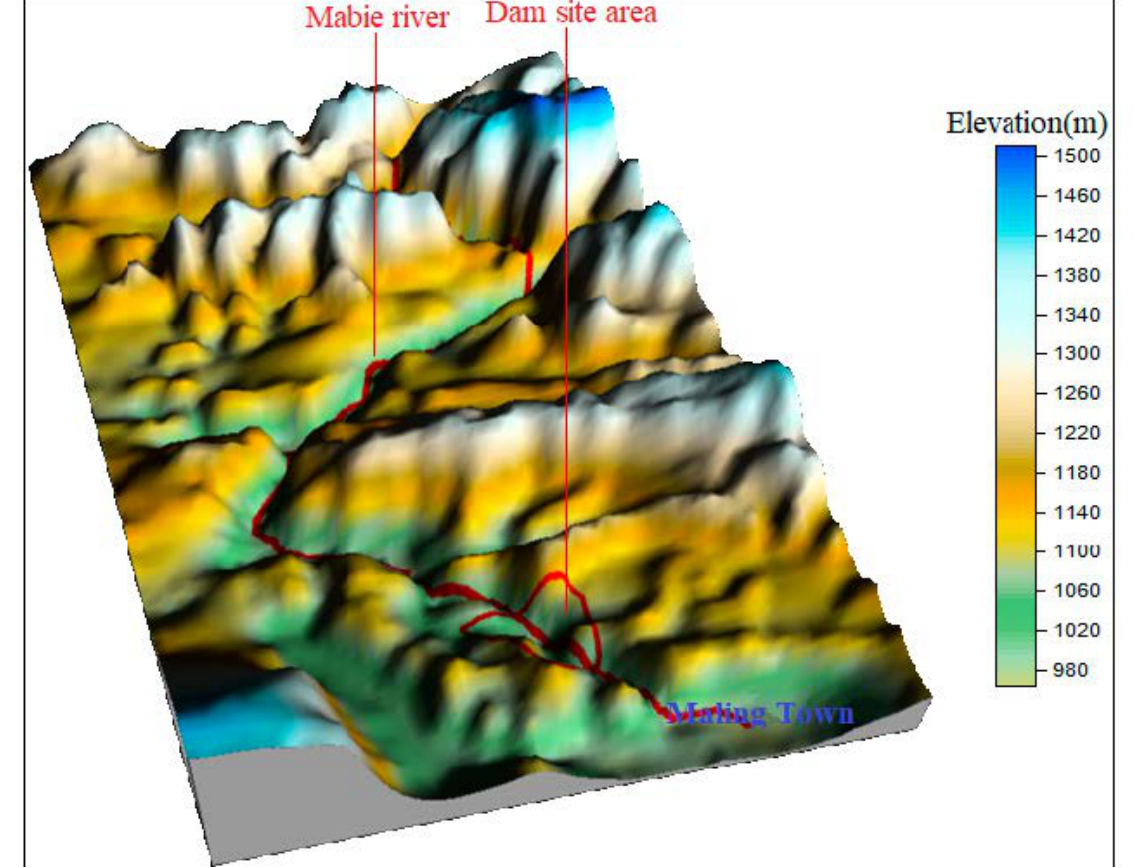
Figure 2. Topography of the Maling Water Conservancy Project (MWCP).